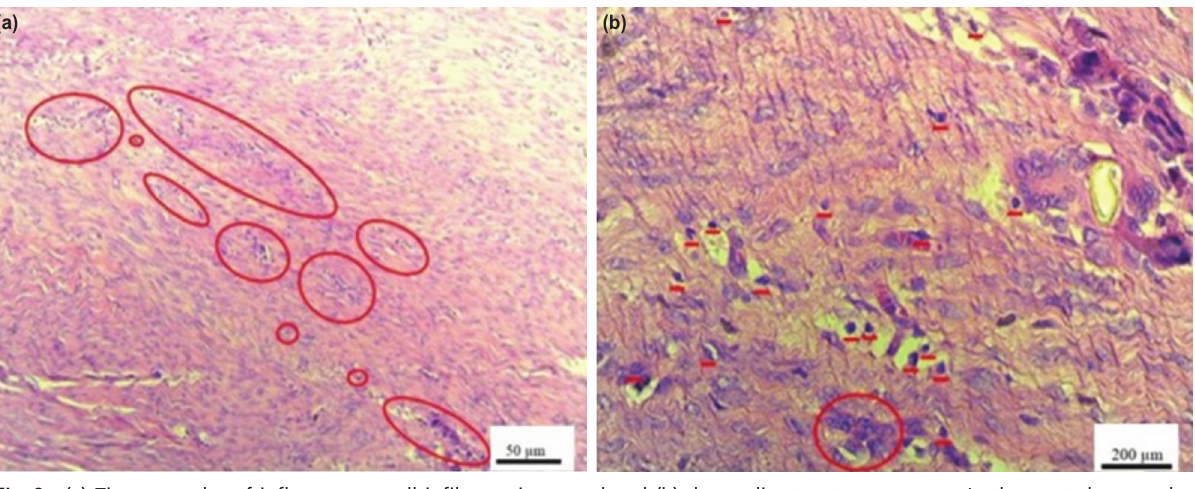
(a) Tissue samples of inflammatory cell infiltrates in control and (b) doxycycline treatment groups. In the control group the Fig. 2: highest inflammatory cell infiltration and in the treatment group the inflammatory cell infiltration decreased compared to the control group. (H&E magnification A 10 ×, scale bar 50 µm, B 40×, scale bar 200